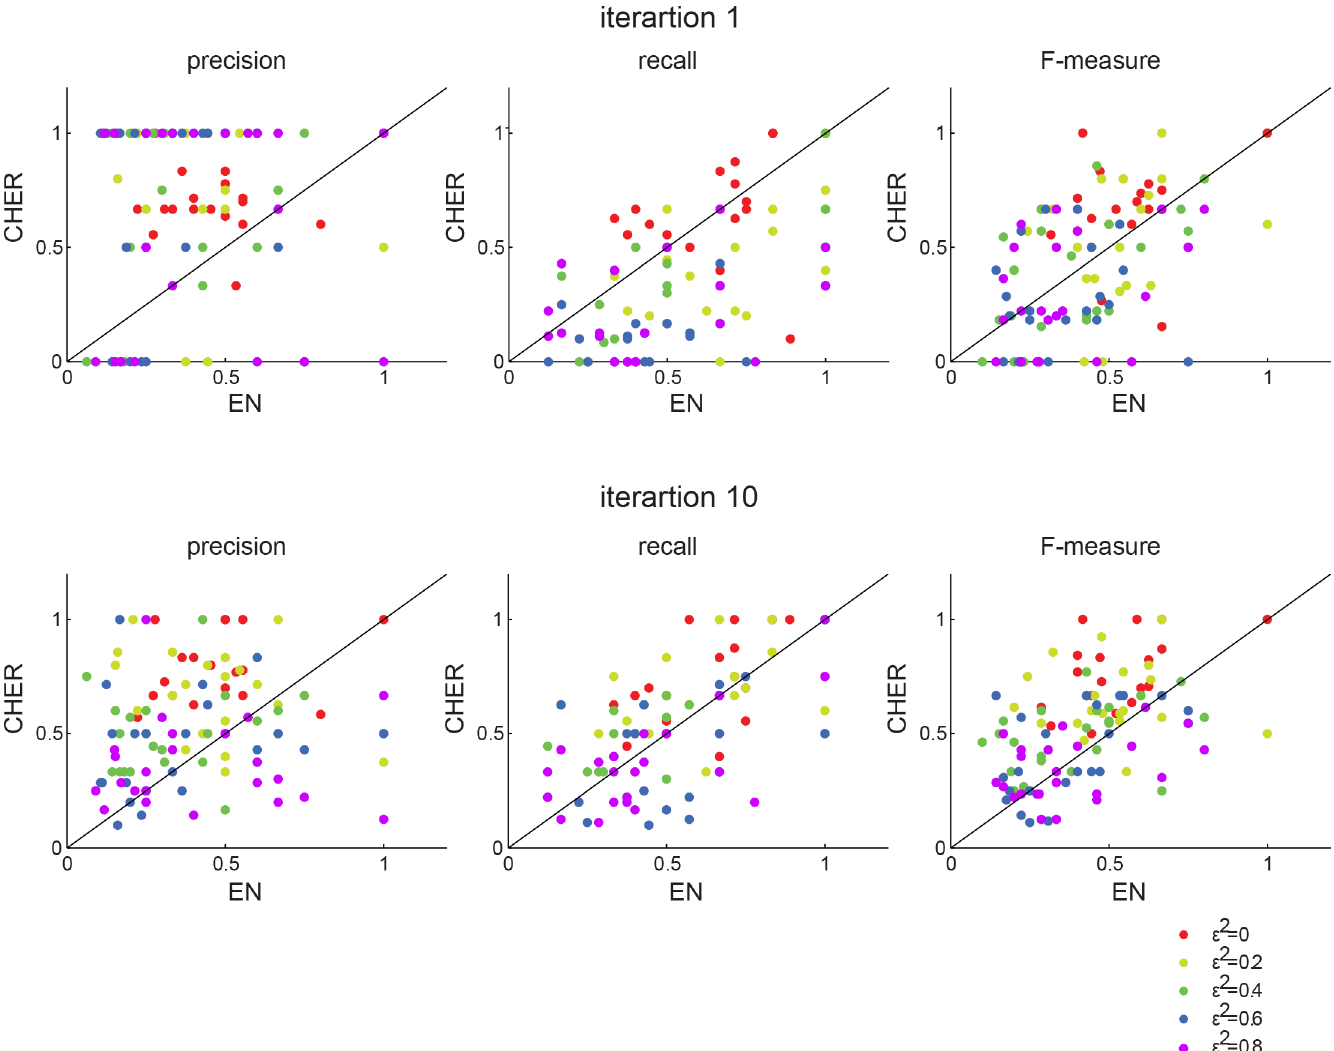
Fig 2. Comparison of performance of CHER and elastic net on synthetic data. Bootstrapped elastic net (EN) is compared to bootstrapped CHER. A threshold of 0.3 and 0.5 are applied to the relevant frequency ( τ ) to determine robust features in CHER and elastic, respectively. The precision, recall, F- measure of each phenotype from EN (x-axis) is plotted against that from CHER (y-axis). The first row shows the results of CHER from the first iteration and the second row the results of CHER from the 10 th iteration. Each dot represents a phenotype, colored by the noise level